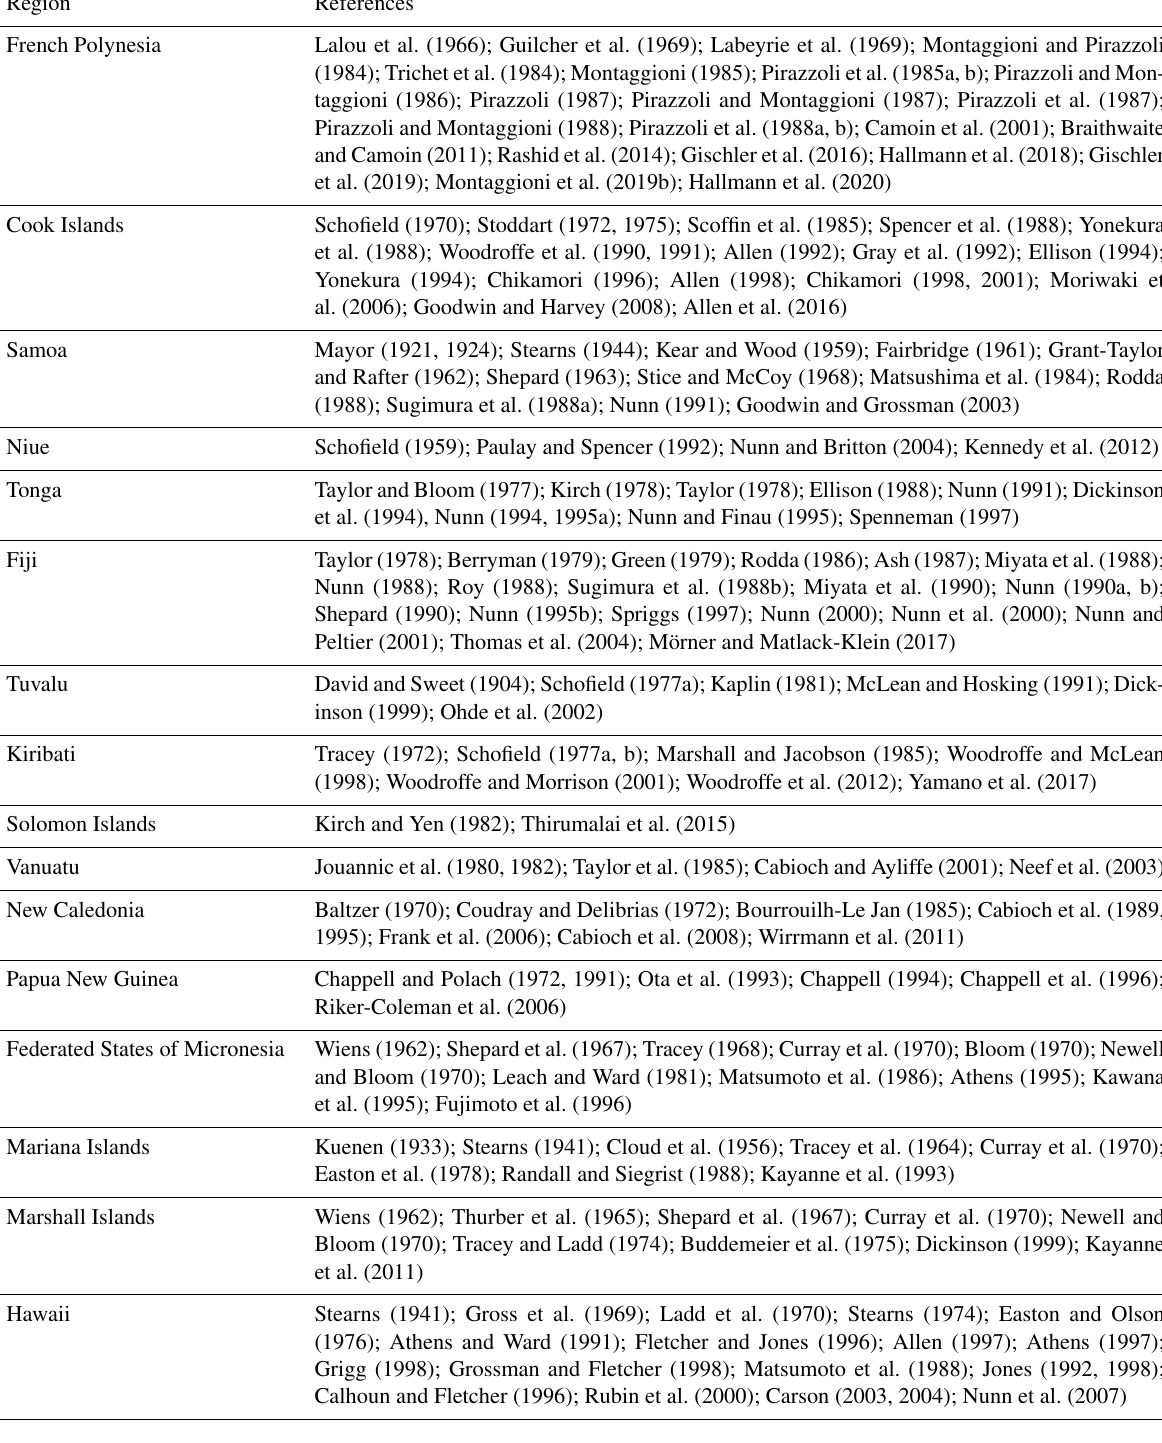
Table 7. Holocene sea-level indicators reviewed in this study.